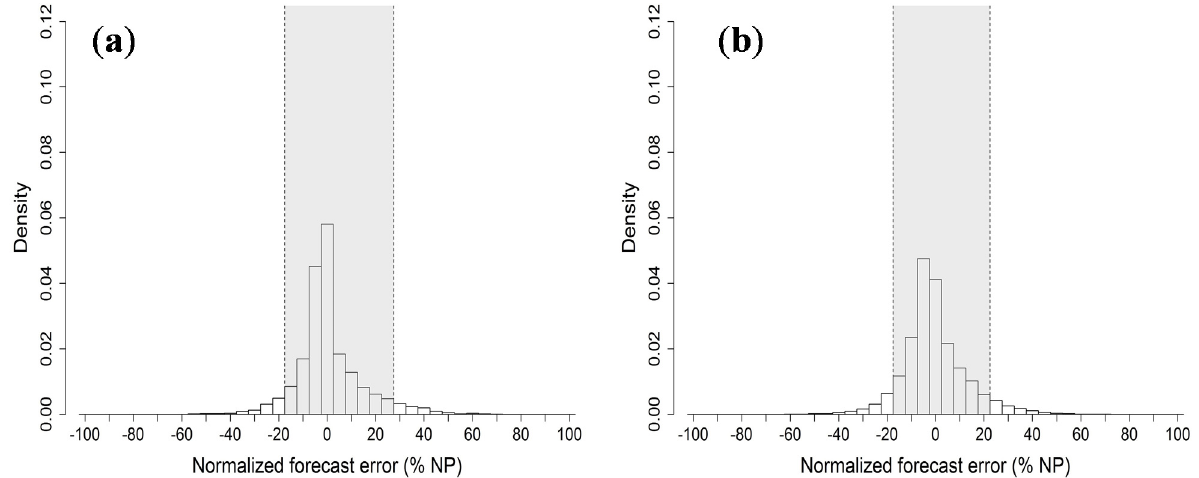
Figure 4. Error distributions (id06) of the best forecasts for the Abruzzo case ( a ) and the Klim case ( b ). The grey area in each histogram delimits the 5%–95% quantiles